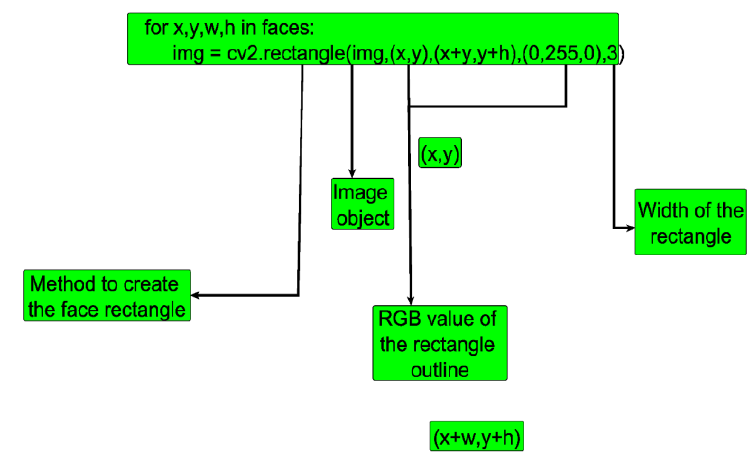
Figure 9. Workflow of the proposed